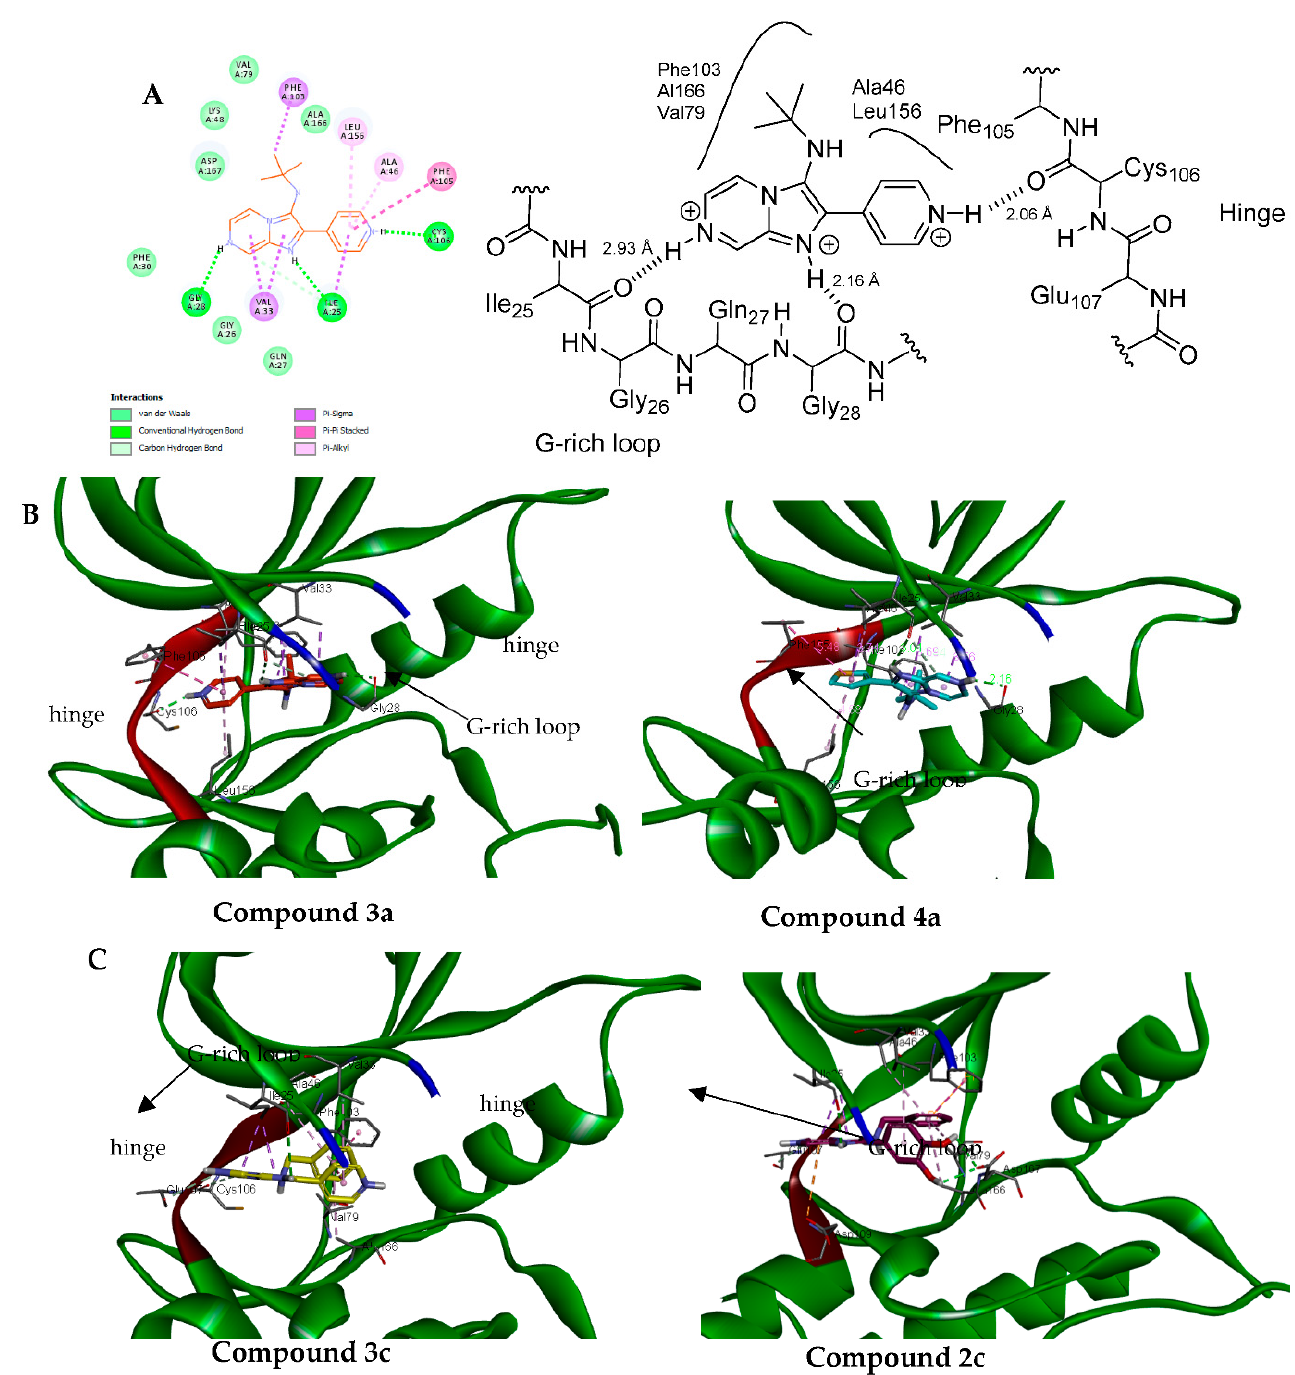
Figure 5. ( A ). Two-dimensional diagram of 3a showing the key binding residues (left) and schematic representation of 3a with CDK9 (right). ( B ): proposed binding mode of 3a (left) and 4a (right) were the imadazo[1,2-a]pyrazine occupies the G-rich loop. ( C ): proposed binding mode of 3c (left) and 2c (right) where imadazo[1,2-a]pyrazine core interacts with hinge.